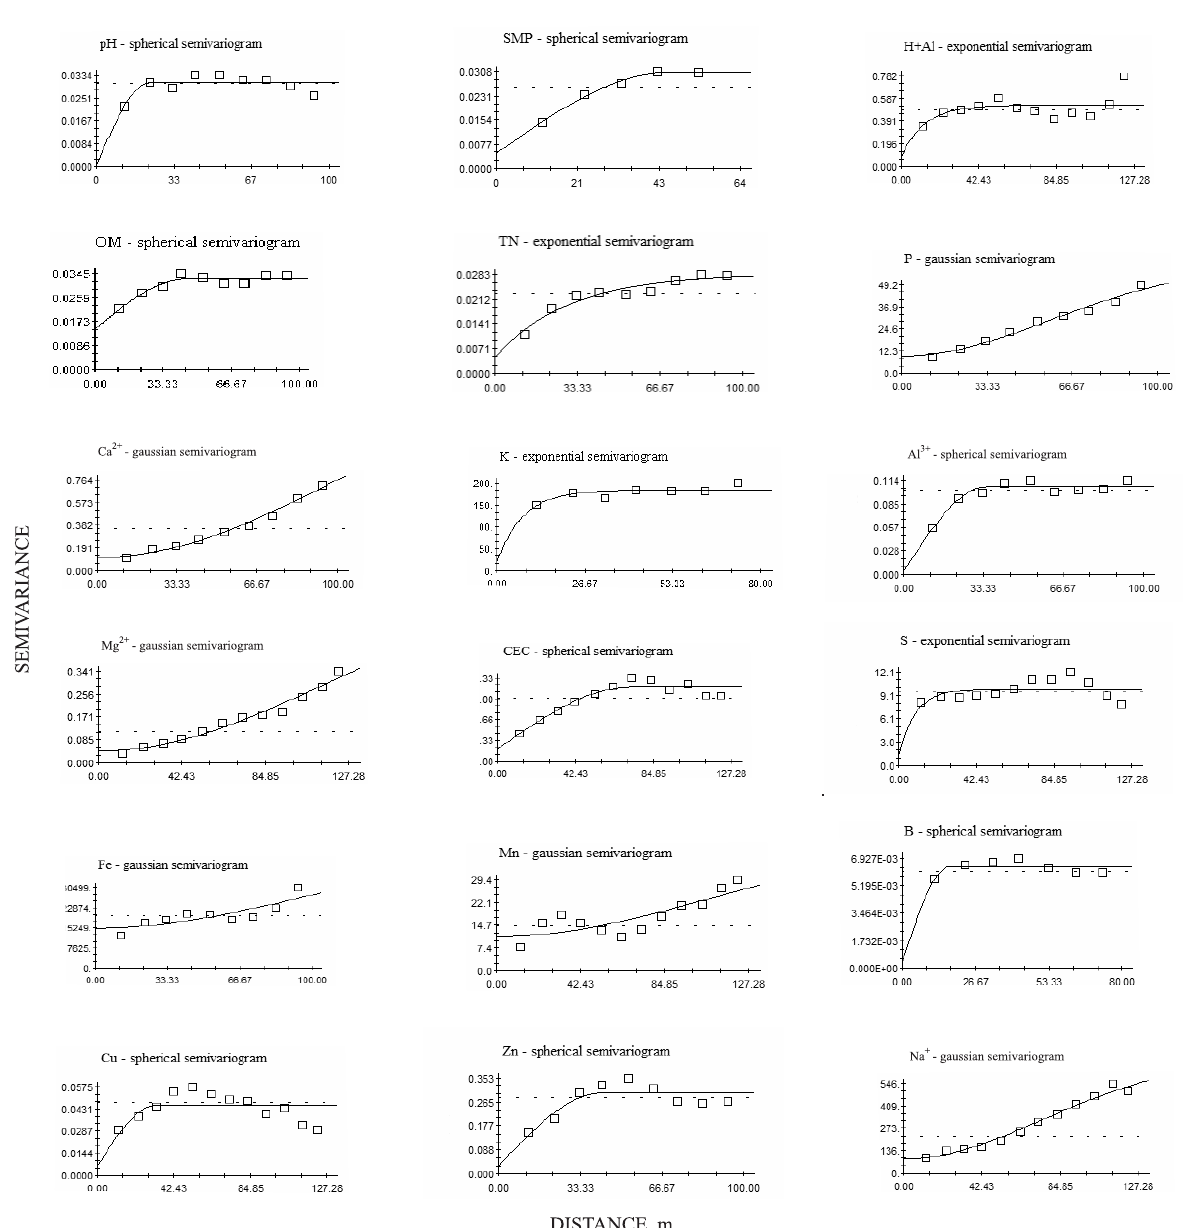
Figure 1. Isotropic experimental and theoretical semivariograms of the chemical properties in lowland soil cultivated with irrigated